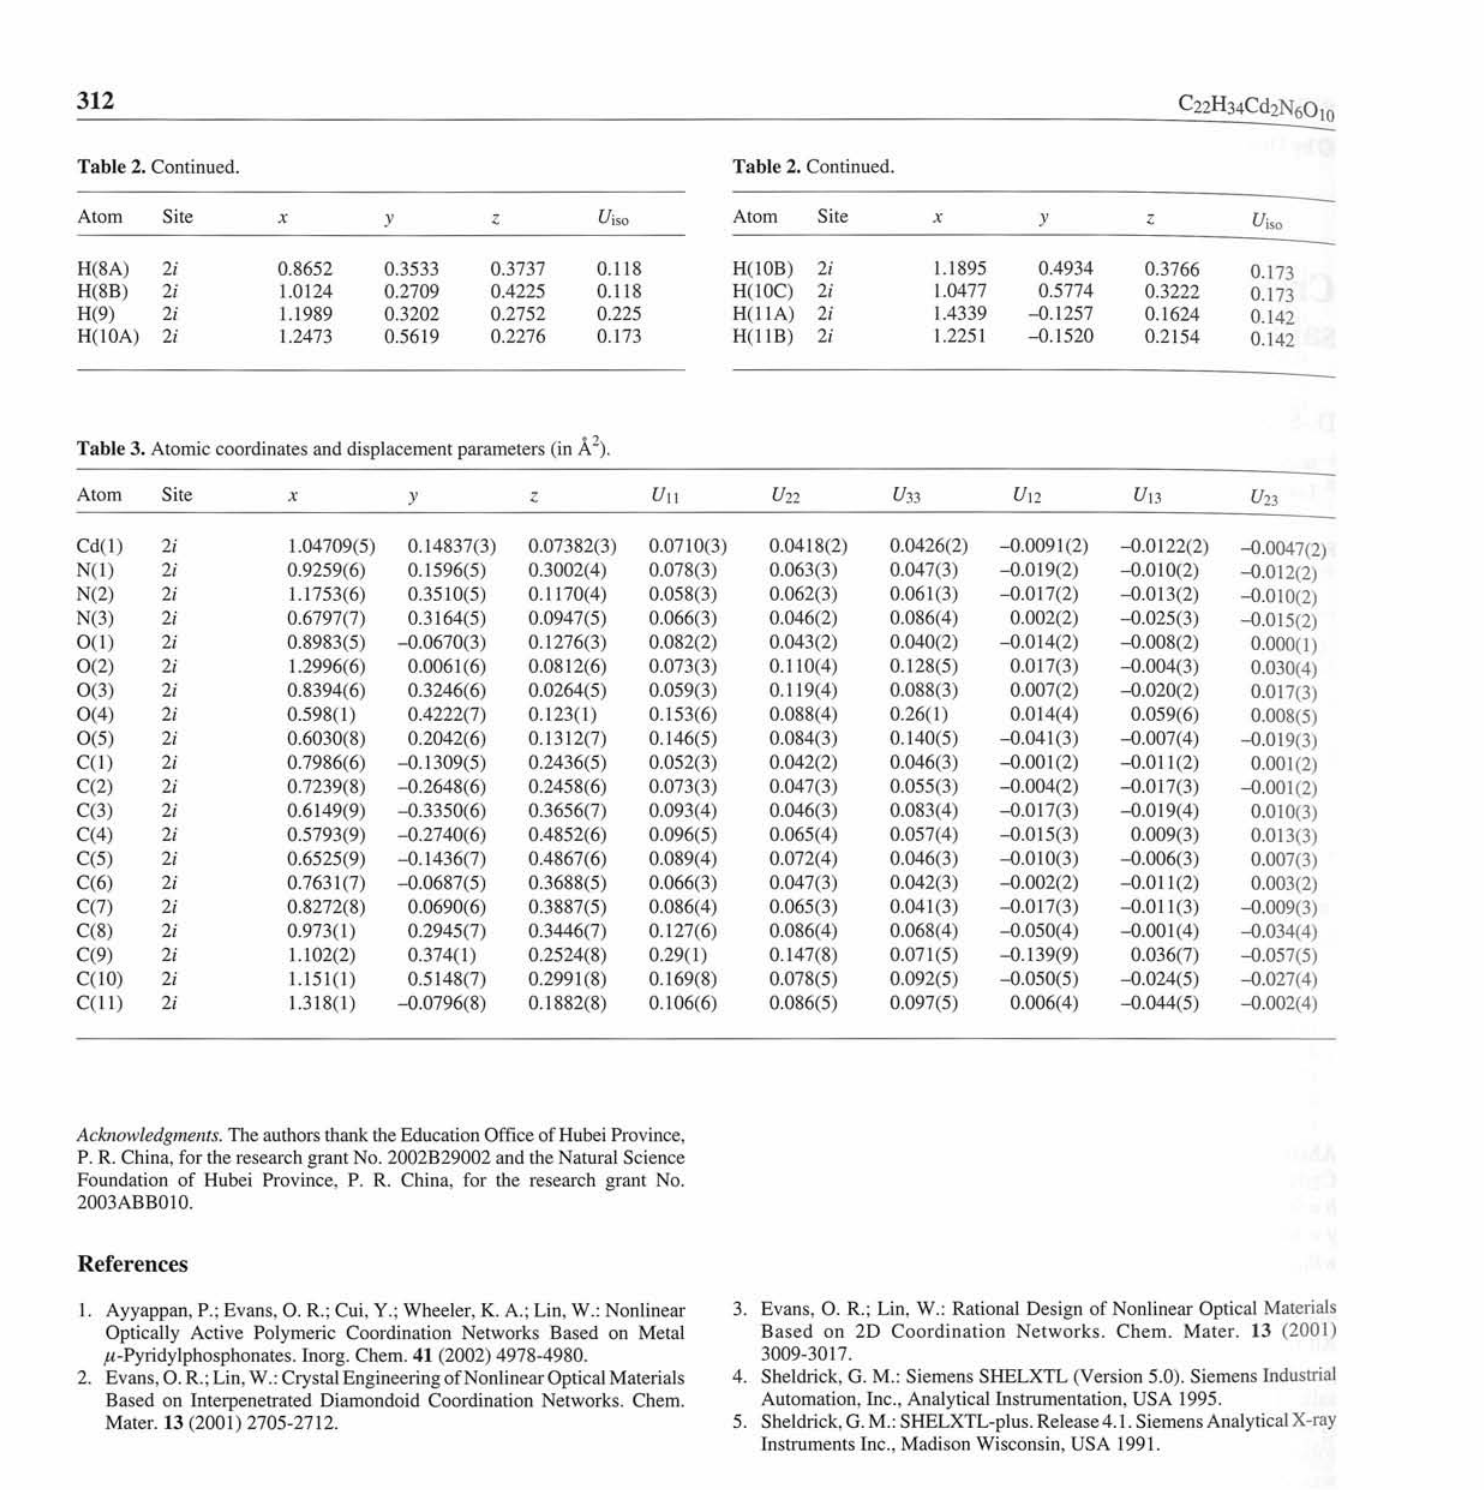
Table 3. Atomic coordinates and displacement parameters (in Â 2